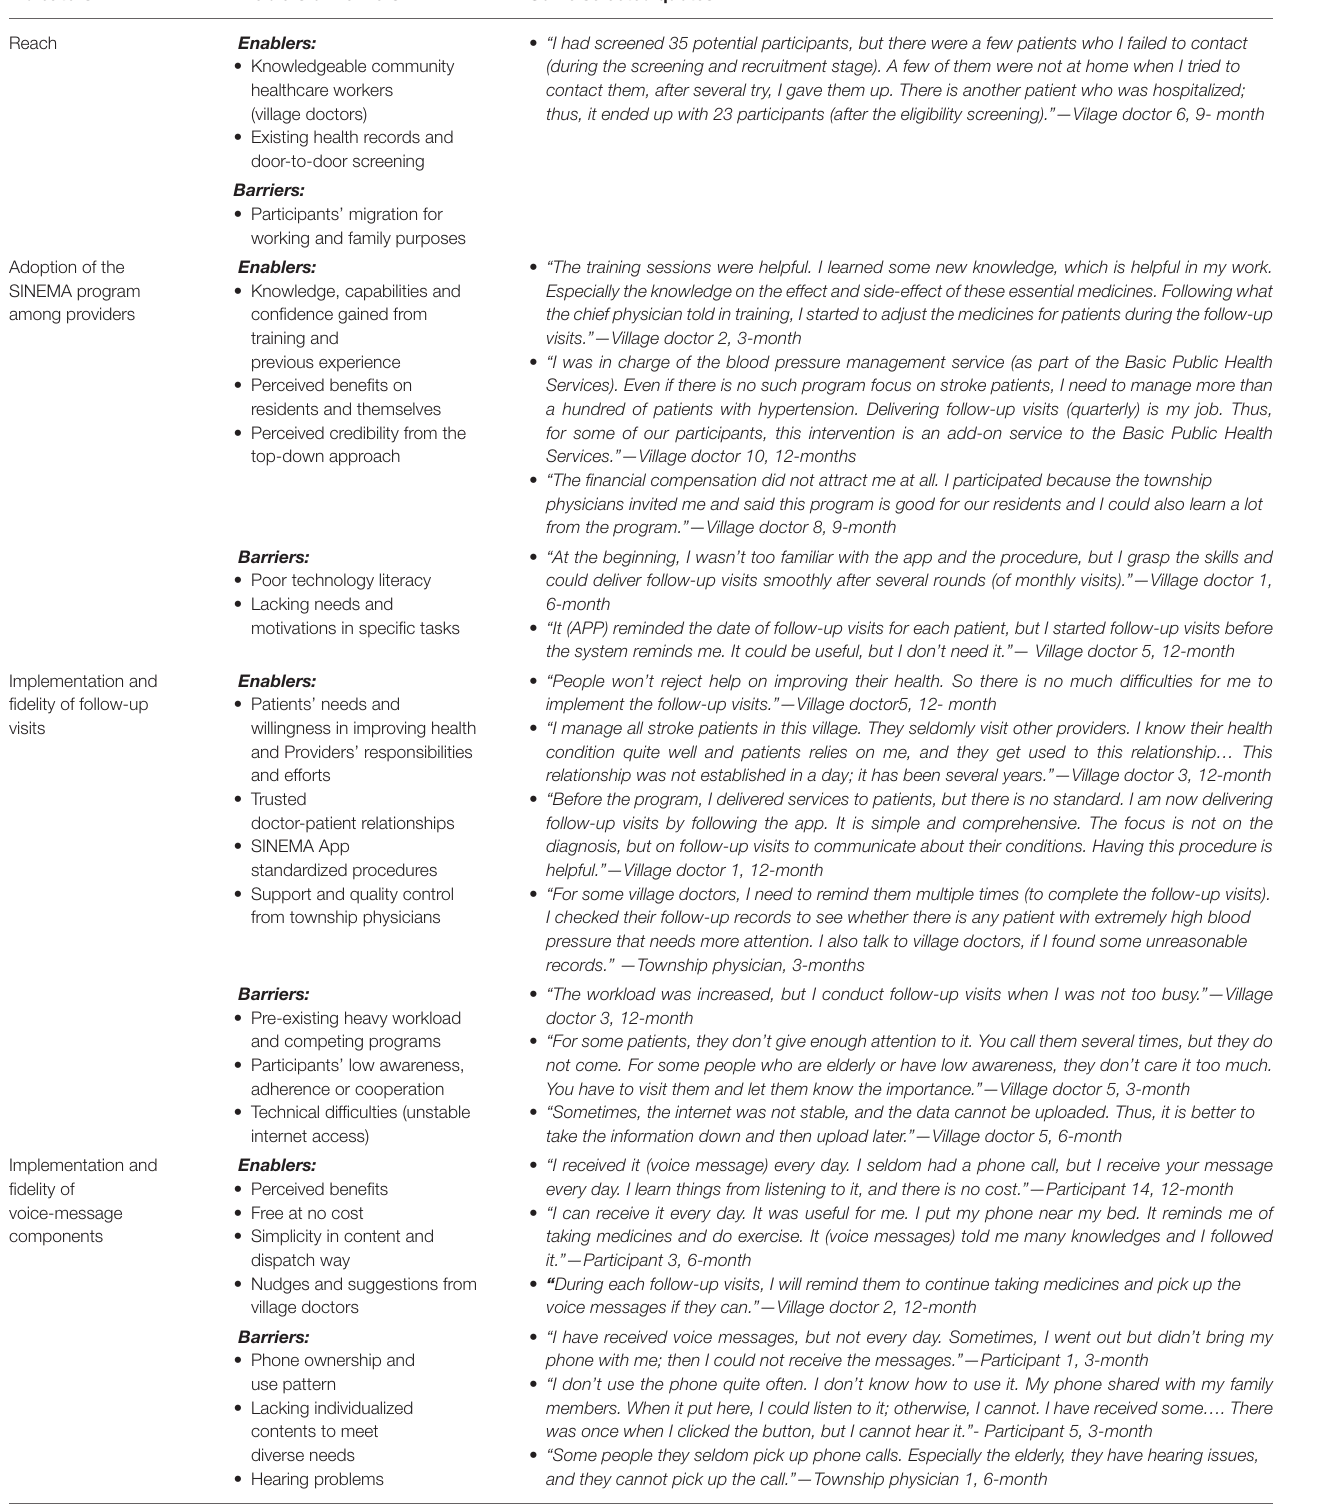
TABLE 4 | Enablers and barriers on implementation